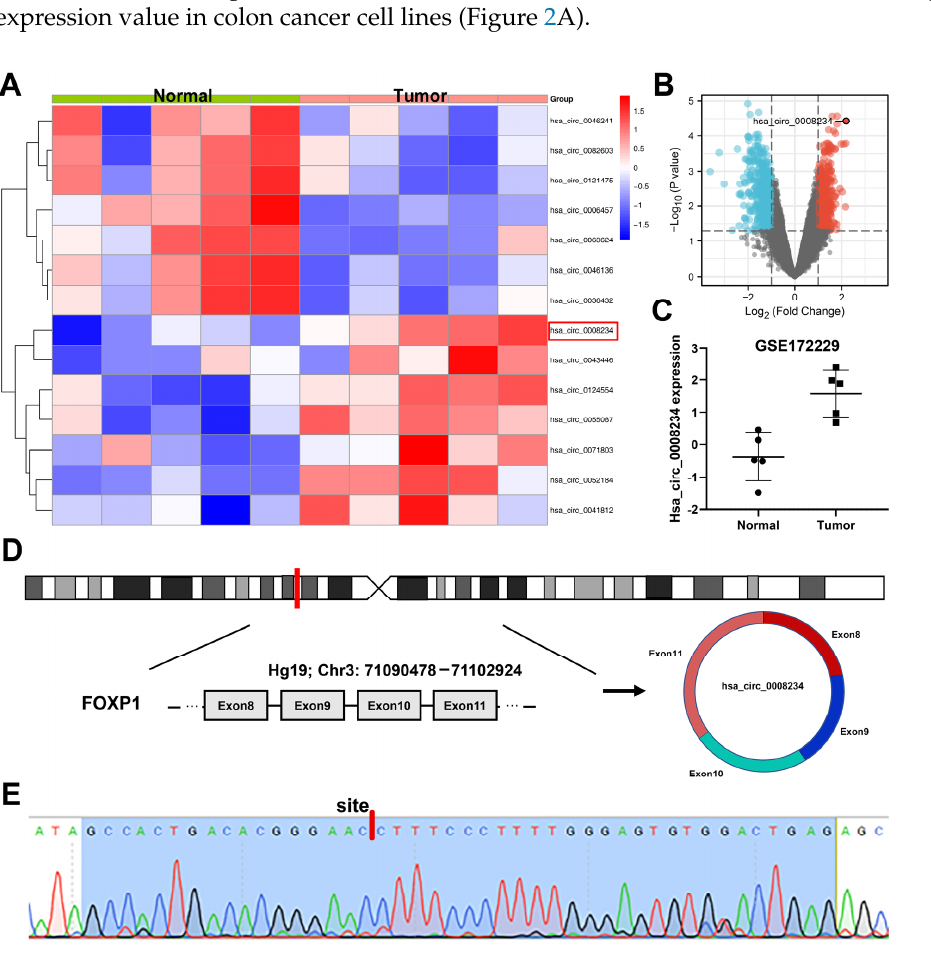
Figure 1. Identification and validation of hsa_circ_0008234 in colon cancer Notes: ( A ): The highest five increased and decreased circRNAs between the normal and colon cancer tissue obtained from the GSE172229. ( B ): Volcano plot of the differentially expressed circRNAs with the threshold of |logFC| > 1 and p < 0.05. ( C ): Hsa_circ_0008234 was upregulated in the colon cancer tissue based on the GSE172229. ( D ): The genomic position of hsa_circ_0008234. ( E ): The RT-PCR results of has_circ_0008234 were sequenced using the Sanger sequencing method. The location of the splice is highlighted by the black arrow of hsa_circ_0008234.